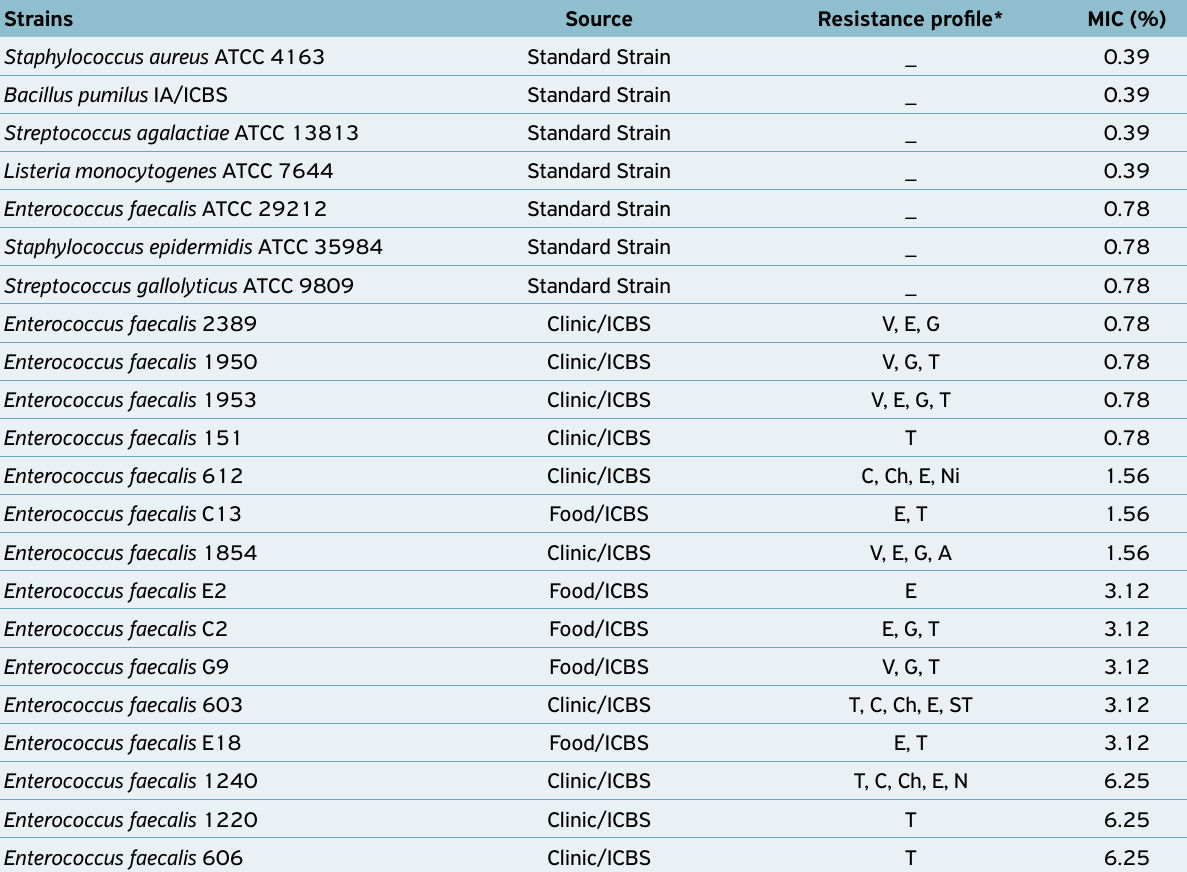
Table 3. Minimum inhibitory concentration values of essential oil of dried leaves of Eucalyptus staigeriana (EO dl ES) against gram‑ positive